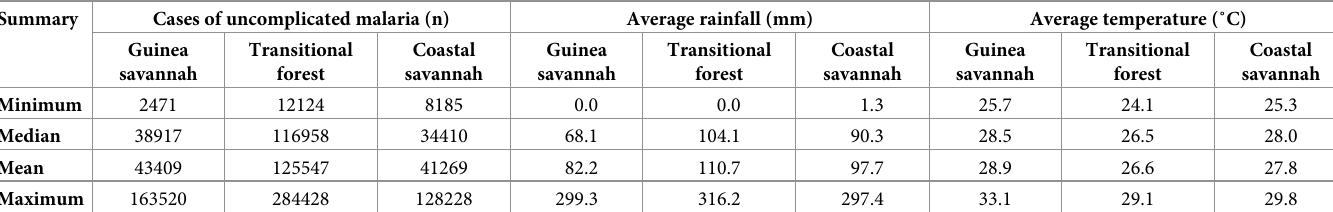
Table 1. Summary statistics of data series for Guinea savannah, Transitional forest and Coastal savannah